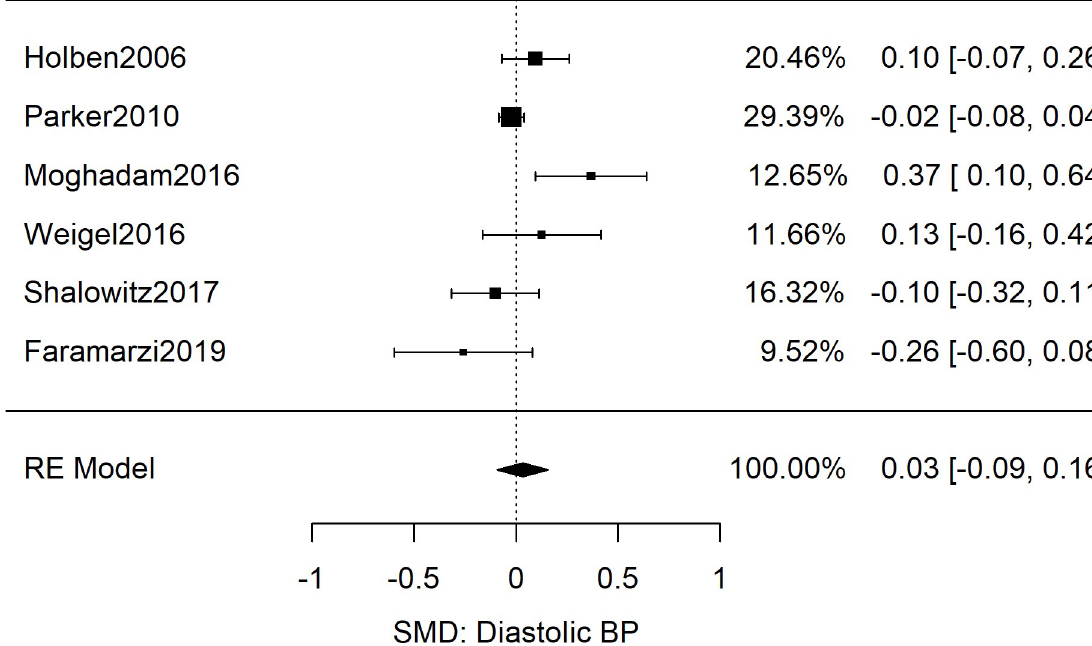
Fig 2. Meta-analysis of adult studies investigating food insecurity and hypertension by blood pressure measurement. Presented are the seven adult odds ratio studies involving direct blood pressure measurements, showing decreased variability in effect sizes and a non- significant combined odds ratio of 0.91 [95%CI: 0.79, 1.04; n = 29,781; Q ( df = 6) = 7.6; I 2 = 21%].